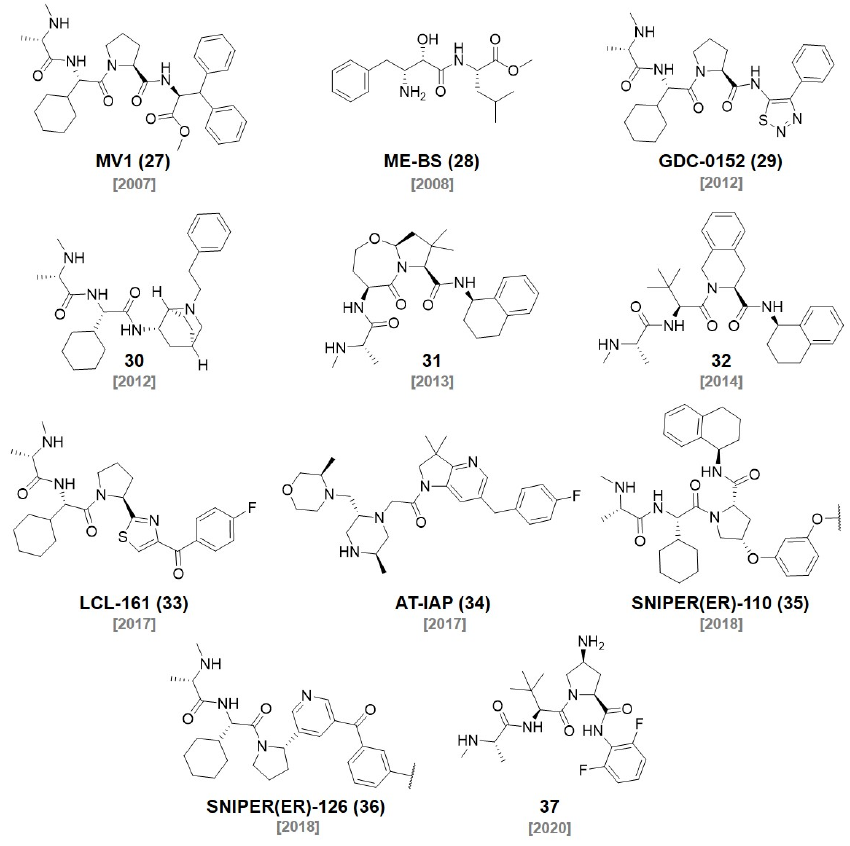
Figure 7. Representative examples of IAP ligands.